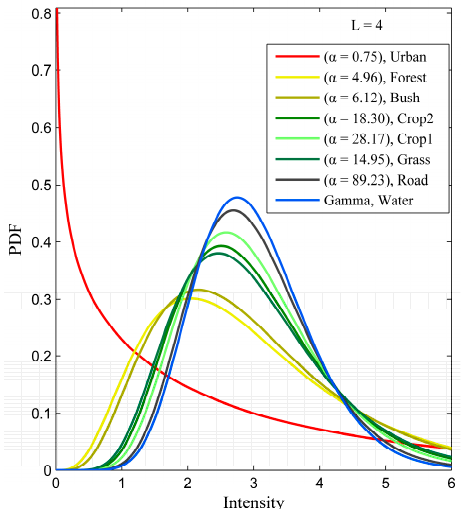
Figure 5. Intensity curves for each simulated class datum after tr(Σ (cid:2879)(cid:2869) T) transformation.